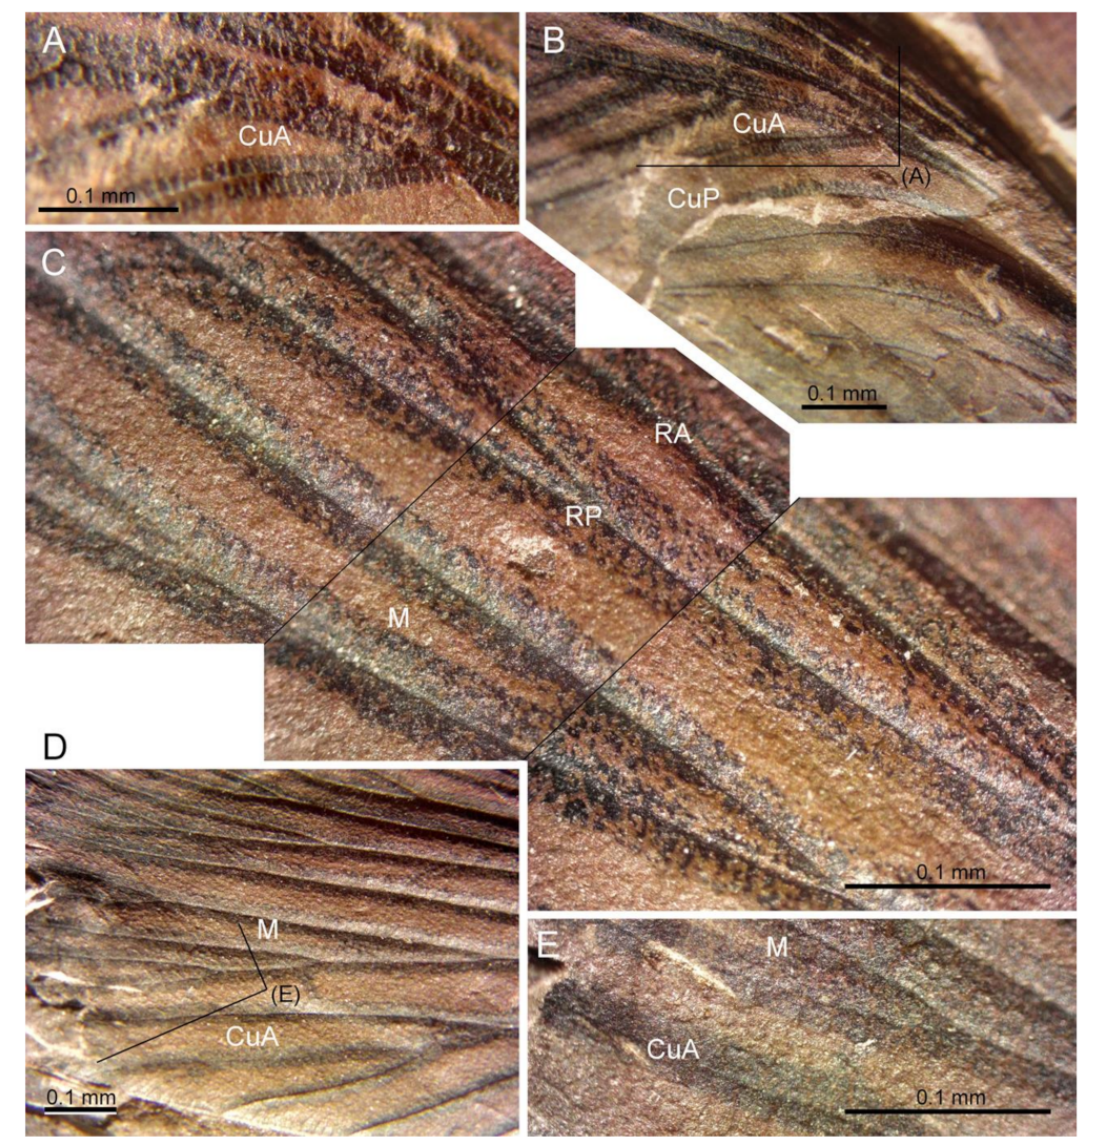
Figure 3. Sysciophlebia ‘sp. form Villablino’ (Spiloblattinidae), MGM-814Ha (part), Orallo mine (Villablino, Le ó n Province), details of forewing venation and colour pattern. ( A ) First branches of CuA. ( B ) Mid-basal fourth of wing, rectangle corresponding to ( A ). ( C ) R with base of RA and basal branches of M. ( D ) Distal parts of M and CuA, rectangle corresponding to ( E ). ( E ) Apical part of CuA and M. Image ( C ) composed of three photographs. Abbreviations: CuA = cubitus anterior; CuP = cubitus posterior; M = median; RA = radius anterior; RP = radius posterior; ScP = subcosta posterior. Diagnosis. Forewing characters only. Forewing of medium size, ca. 22 mm long, reduced darkened zones between main veins and along wing margin (where they are continuous); presence of darkened spots in distal part of area between branches of MP; a hyaline zone between veins RA and RP and in zone covered by basal part of branches of